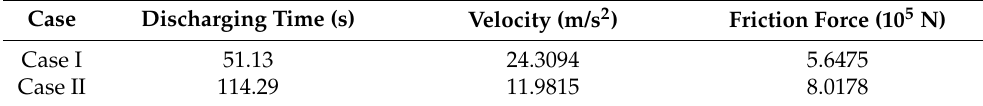
Table 2. Discharging time, velocity, and friction force of the fluid discharge under two different cases.